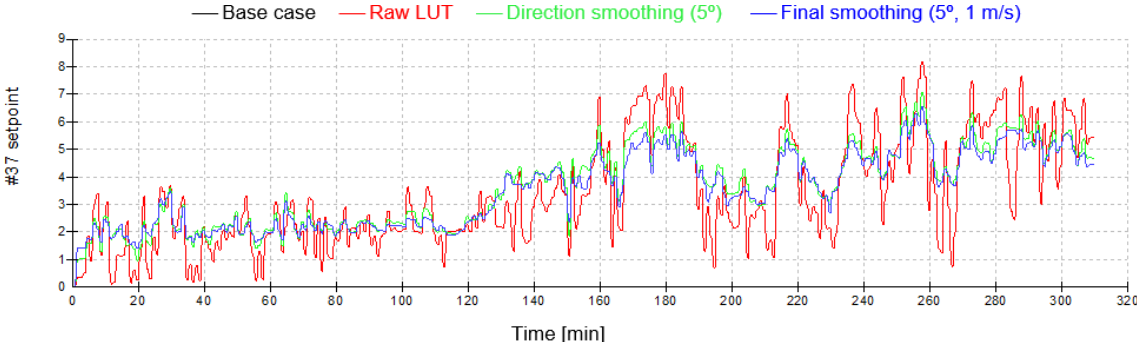
Figure 8. Effect of LUT smoothing on induction control setpoints (turbine no. 37 illustrated). For the base case, the setpoint is zero.